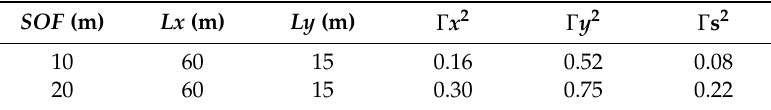
Table 11. Variance reduction